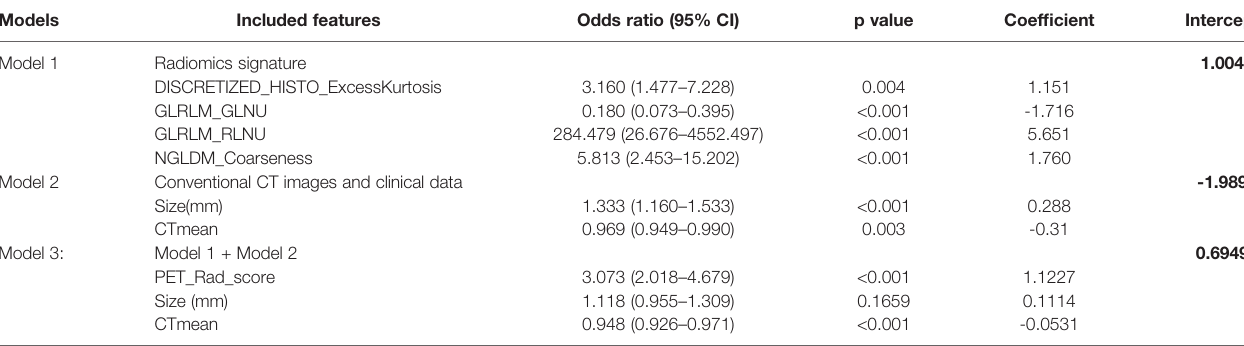
TABLE 3 | Results of multivariable logistic regression analysis in the three